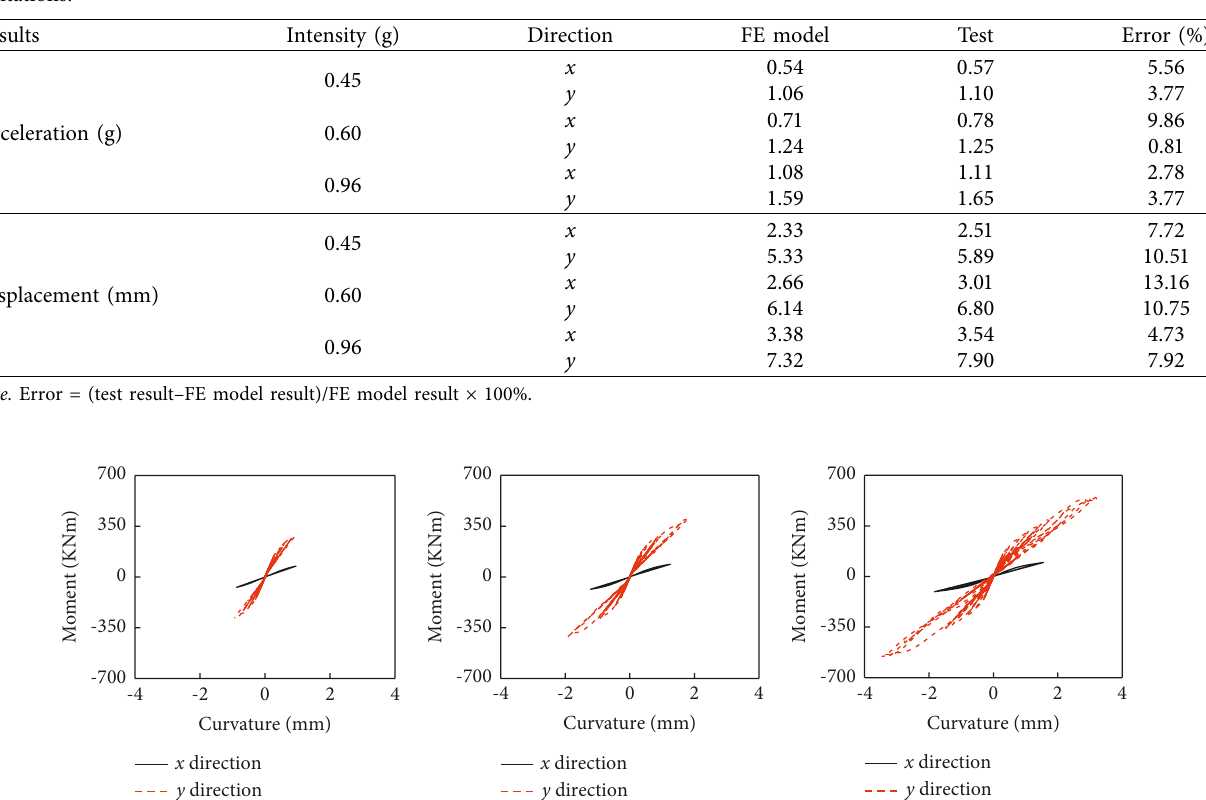
Table 8: Comparison of maximum absolute acceleration and displacement between the FE model and test under different earthquake excitations.